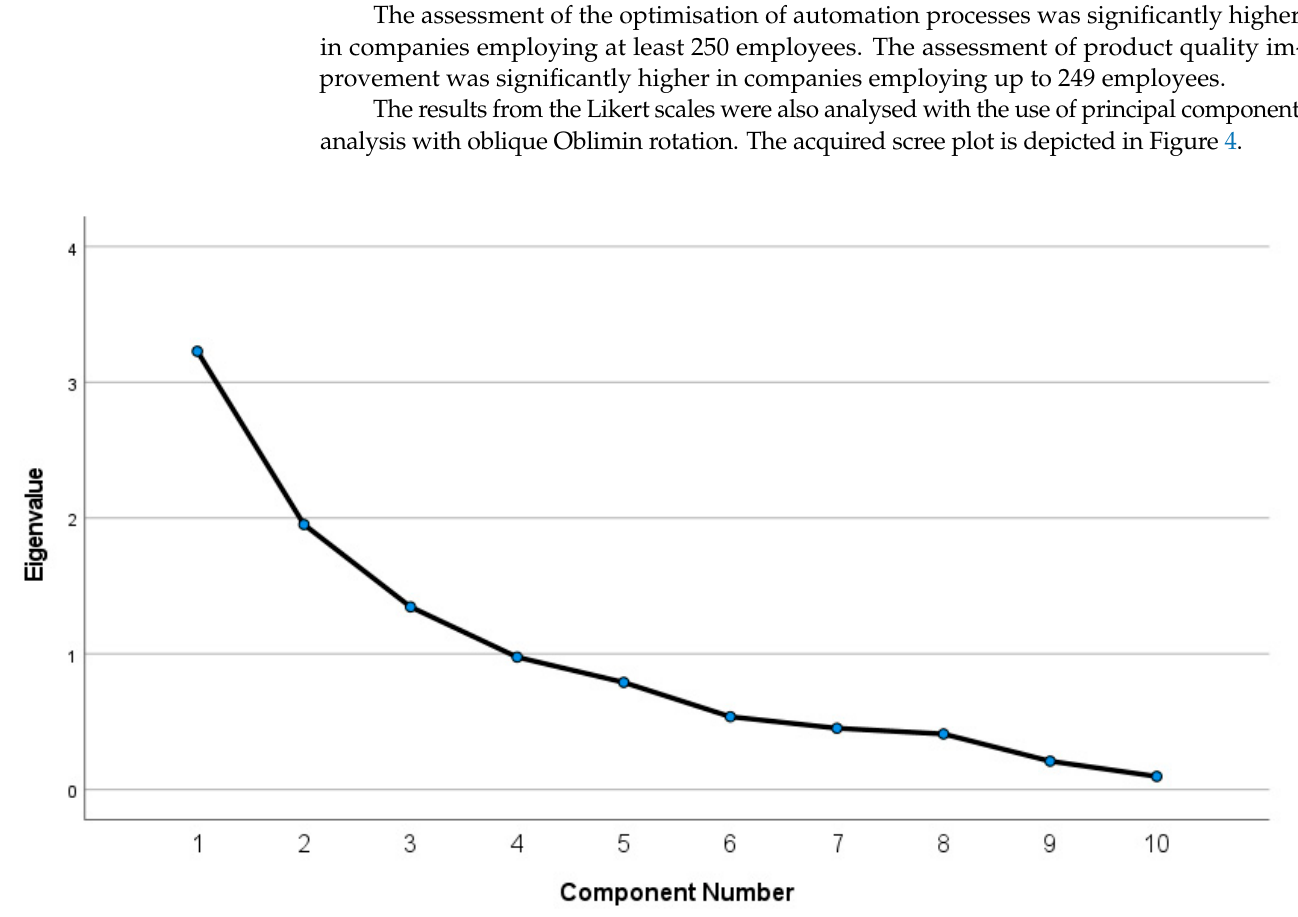
Figure 4. Scree plot in the principal component analysis regarding benefits of implementing Industry 4.0 solutions. Based on the Kaiser criterion, three components were extracted. Table 10 presents factor loadings in a pattern matrix. The values lower than 0.4 were suppressed for